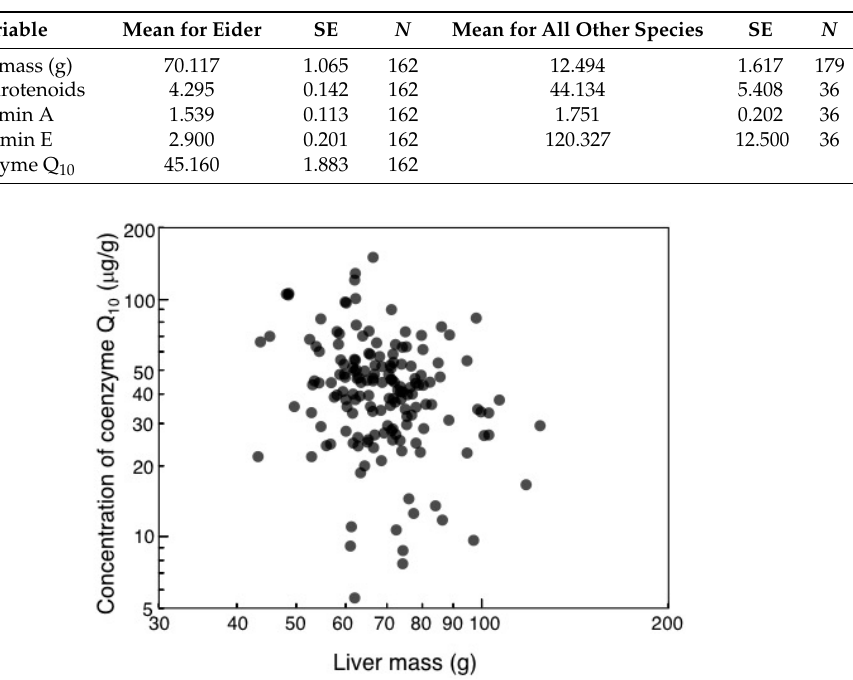
Figure 2. The concentration of coenzyme Q 10 ( µ g/g) in the liver in relation to the mass of the liver in common eiders. The line is the log-log regression line.